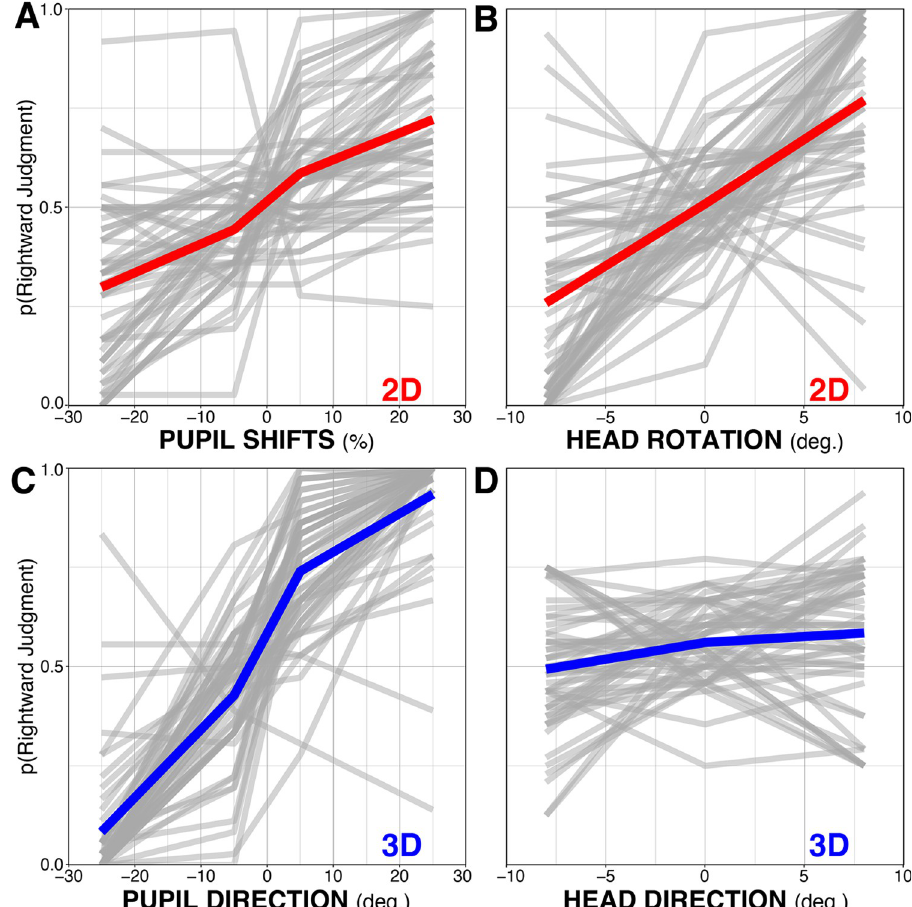
Fig 3. Proportion of rightward judgments as a function of pupil shift (A) and head rotation (B) in the 2D task (red), and pupil direction (C) and head direction (D) in the 3D task (blue). The bold lines represent group-level means. without ASD (pupil cue agreement: non-parametric Wilcoxon Rank Sum test p = 0.46; head cue agreement: non-parametric Wilcoxon Rank Sum test p = 0.89).